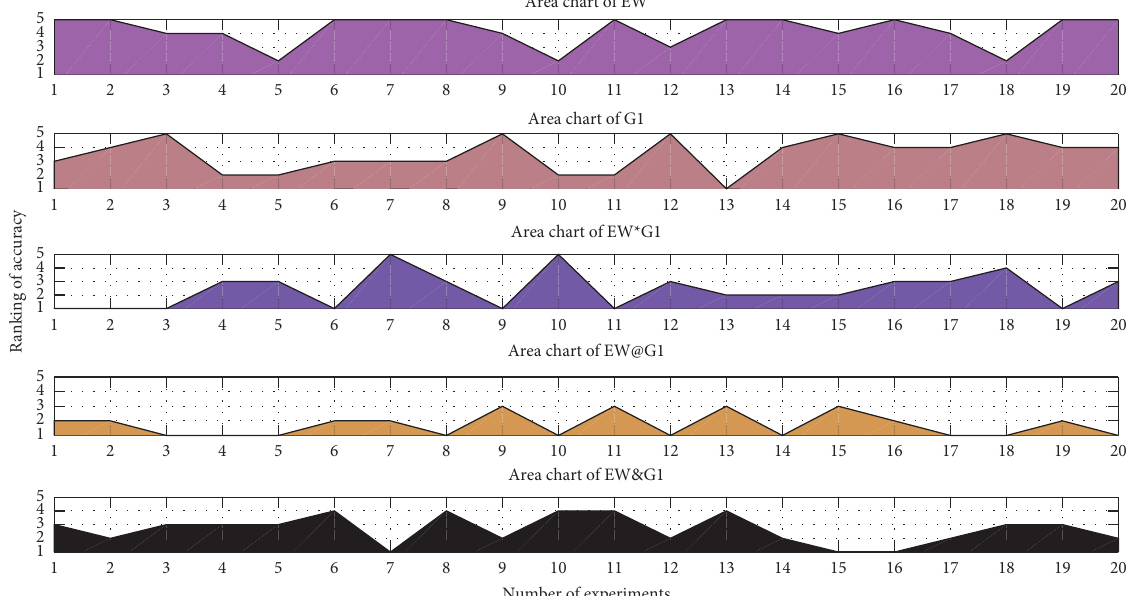
Figure 8: Five diferent weights sort graph.